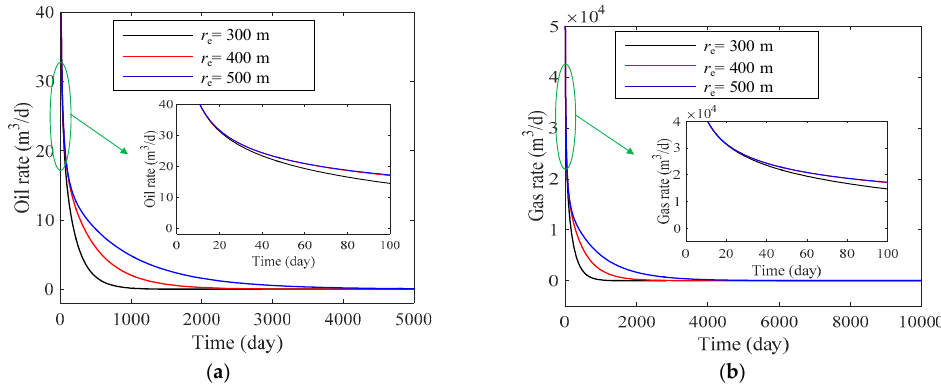
Figure 9. Effect of radial distance of external boundary on production rate: ( a ) effect of radial distance of external boundary on oil production rate; ( b ) effect of radial distance of external boundary on gas production rate.